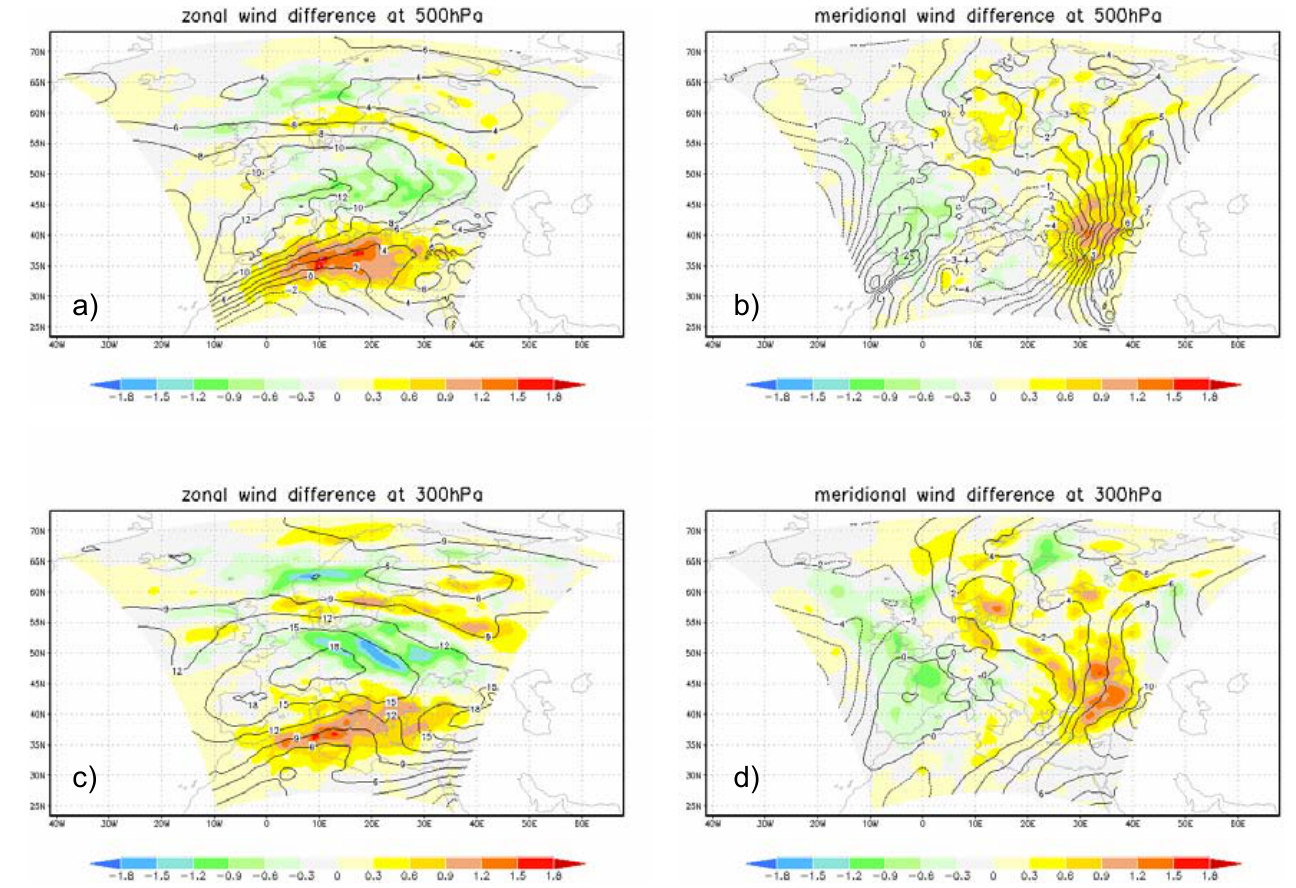
Fig. 6. Seasonal mean fields in summer for the year 2000 of the difference AFrun-Crun RegCM3/aerosol simulations due to aerosol feedback in zonal wind at 500hPa (a) and 300hPa (c) and in meridional wind at 500hPa (b) and 300hPa (d) . The summer seasonal mean fields of zonal and meridional wind in the control simulation (Crun) are superimposed with black contours. The units are in m/s.